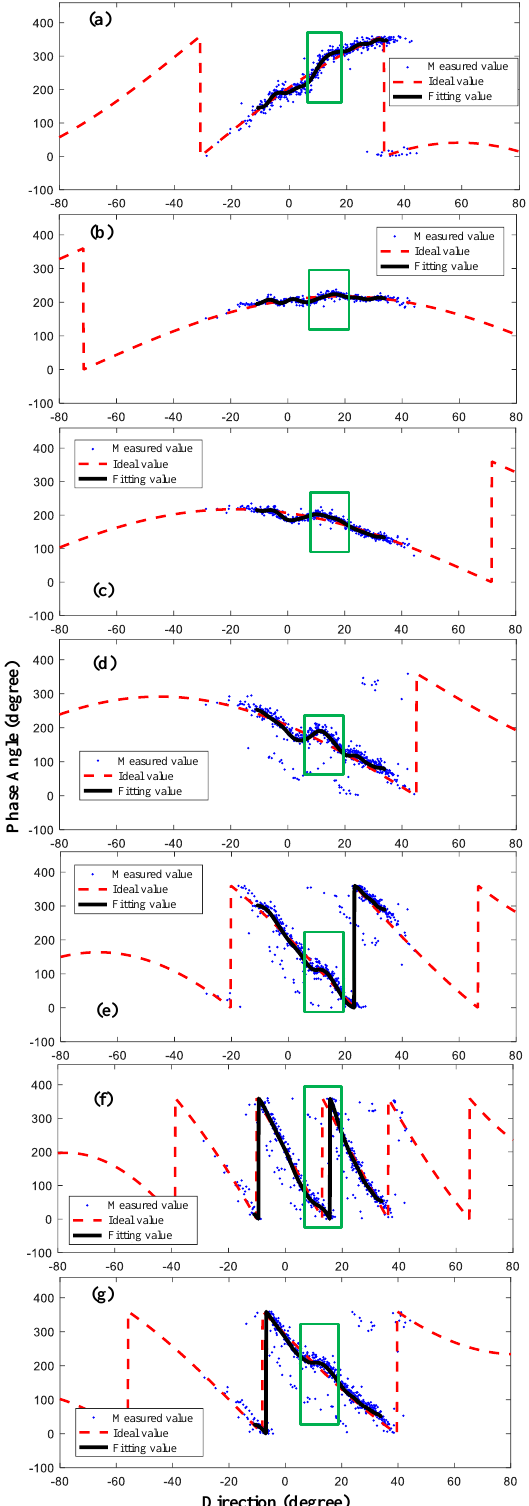
Figure 5. Array phase value measurements at 19.1 MHz. ( a ) Antenna 2; ( b ) Antenna 3; ( c ) Antenna 4; ( d ) Antenna 5; ( e ) Antenna 6; ( f ) Antenna 7; and, ( g ) Antenna